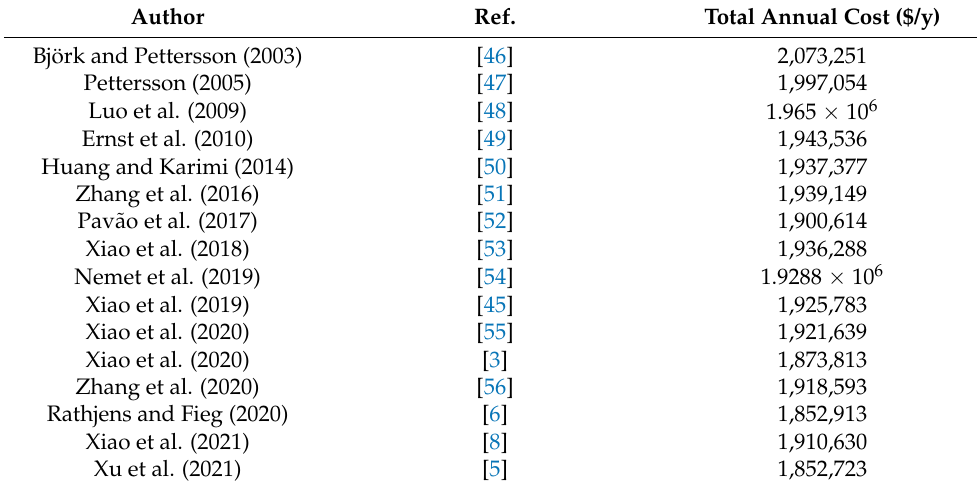
Table 5. Various study results on the optimal total annual cost of HEN for case study